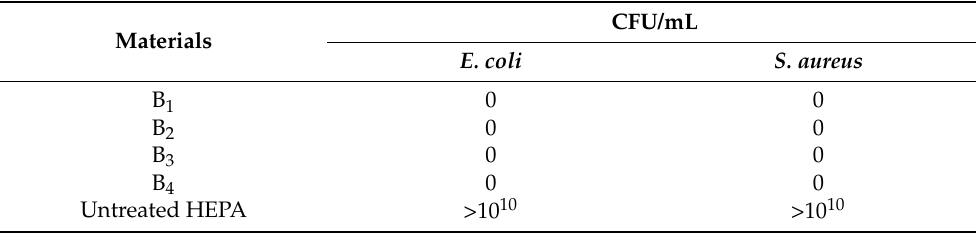
Table 2. The colony forming units (CFU/mL) method indicating the bactericidal/bacteriostatic